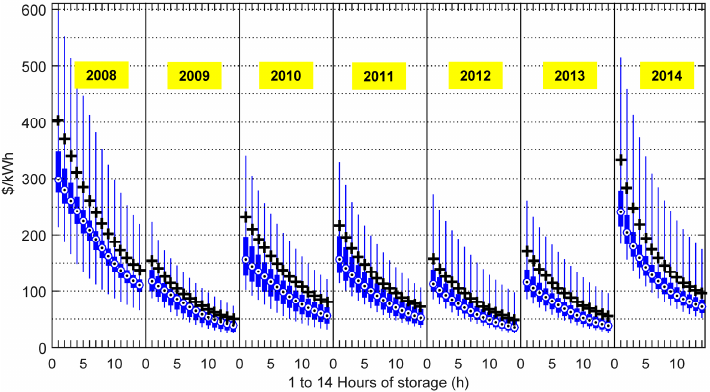
Figure 24. Distribution of breakeven overnight installed cost in the PJM DA-Market for an ESS vs. discharge duration at rated power (1–14 h) for each of the years studied. The thin vertical bars represent the entire range over the 7395 nodes. The thick vertical bars are bounded by the 25th and 75th percentile of the nodes. The circles represent the 50% percentile of the nodes and the black crosses indicate the 95th percentile of the nodes. Assumed round trip efficiency is 90% and project lifetime is 20 years.